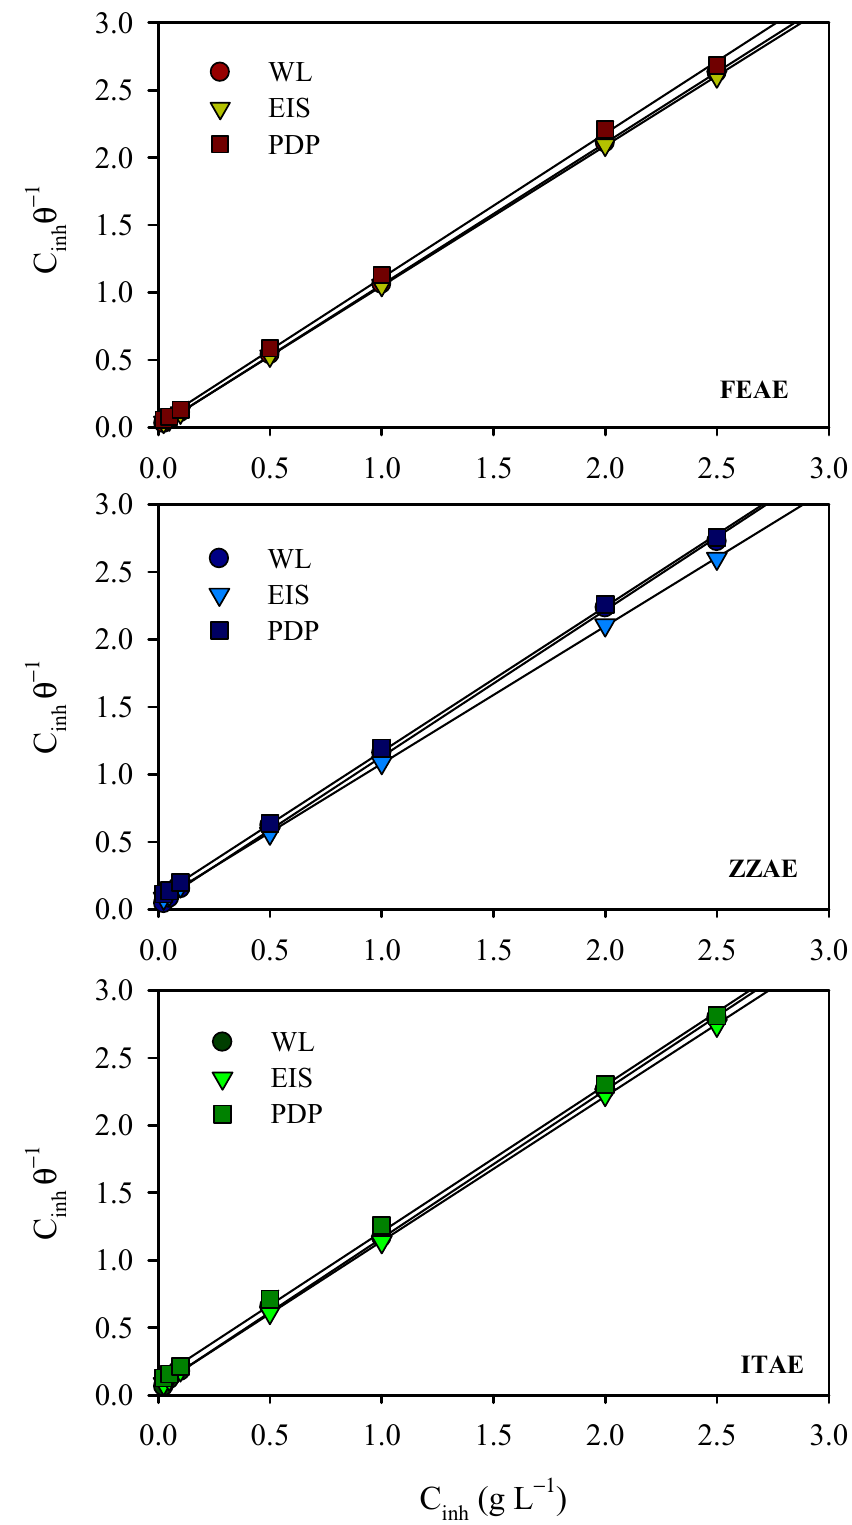
Figure 5. Langmuir adsorption isotherm for the studied plant extracts on mild steel from 2 M H 3 PO 4 .